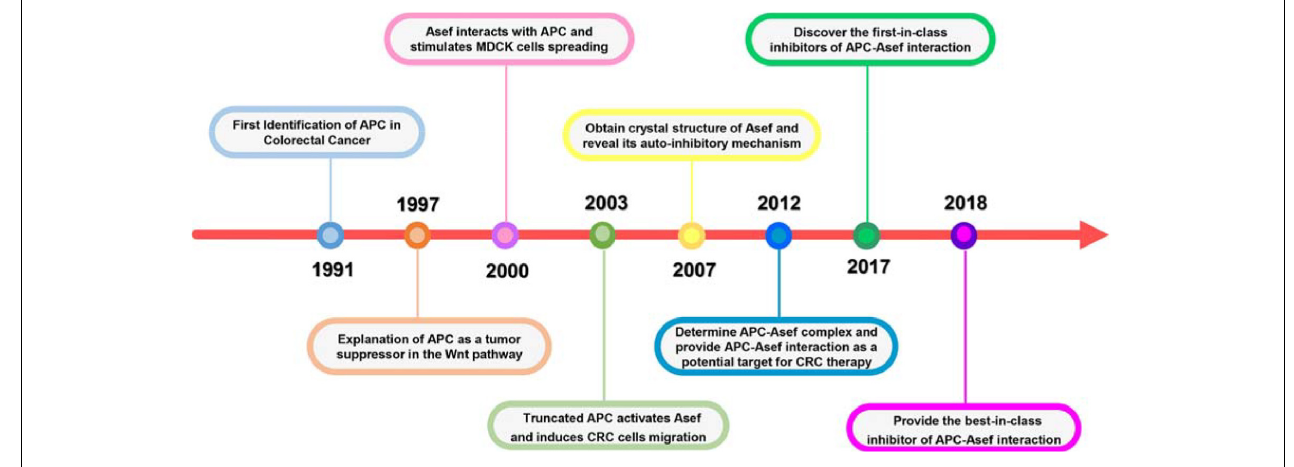
FIGURE 1 | Significant milestones in the history of APC-Asef